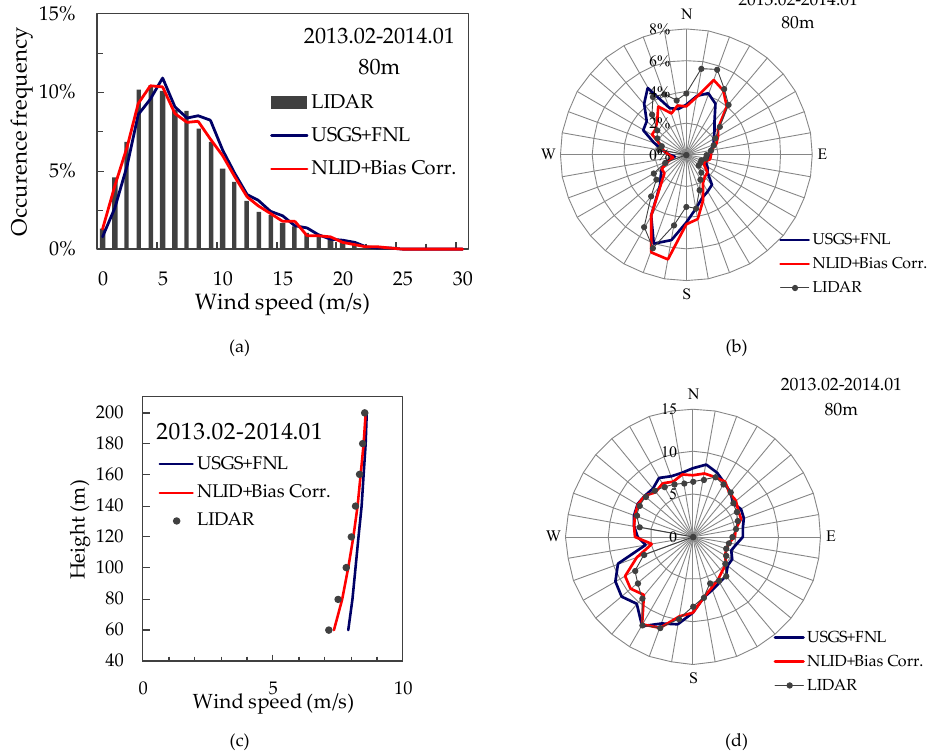
Figure 14. Effect of land-use and bias-corrected SST on the offshore wind. ( a ) Frequency distributions of wind speed at the hub height; ( b ) Wind rose; ( c ) Vertical profiles of annual average wind speed; ( d ) Directional annual average wind speeds.